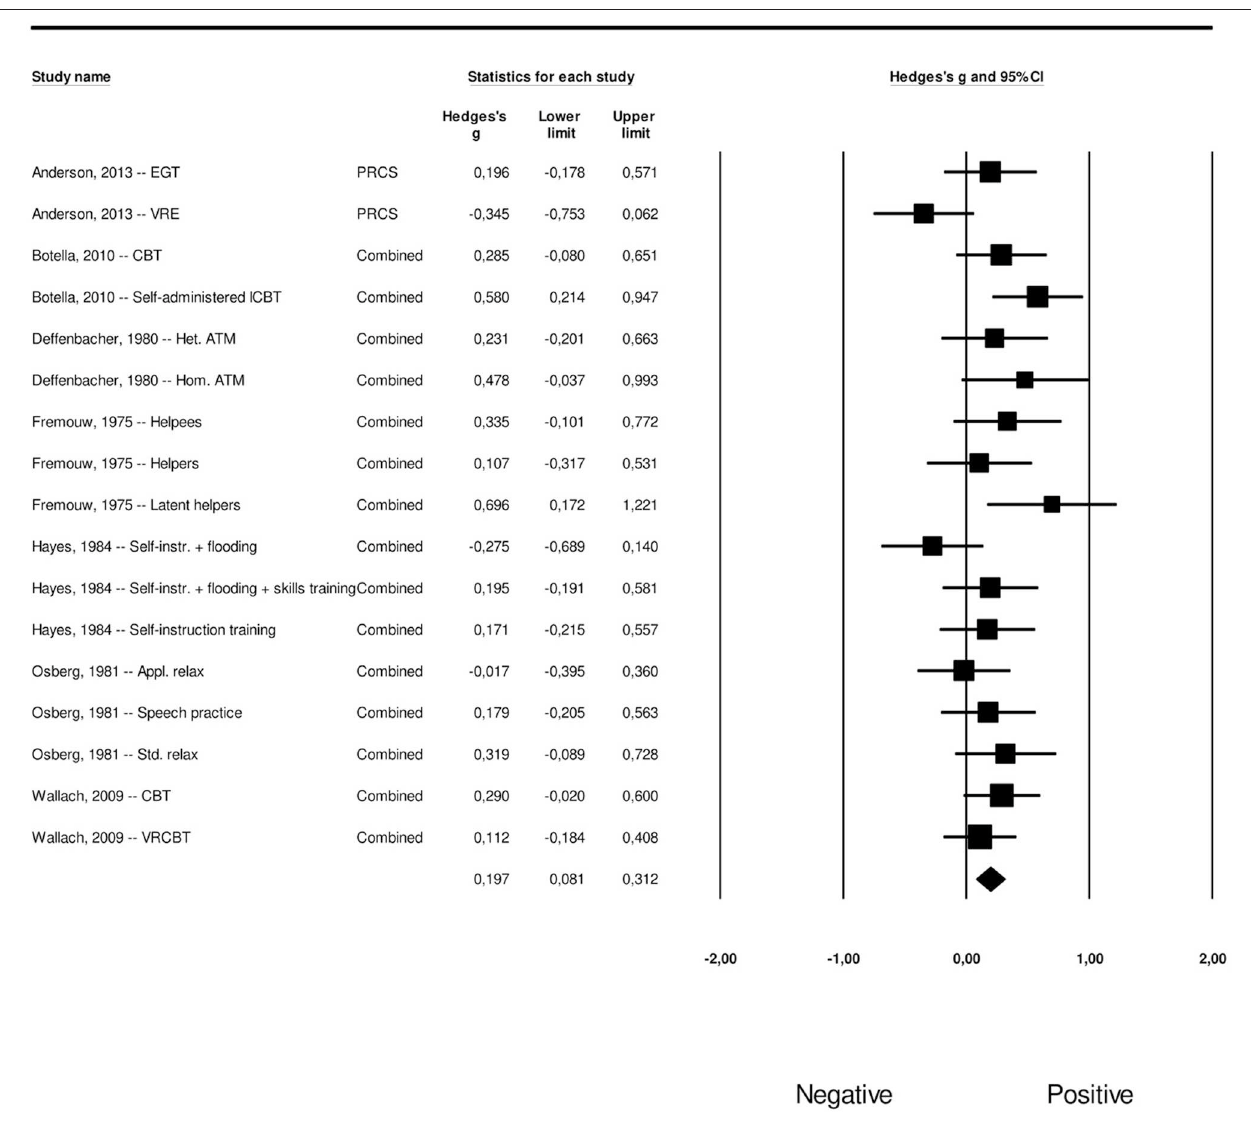
FIGURE 7 | A forest plot of the change in efficacy from post-treatment to follow-up of psychological treatments aimed at fear of public